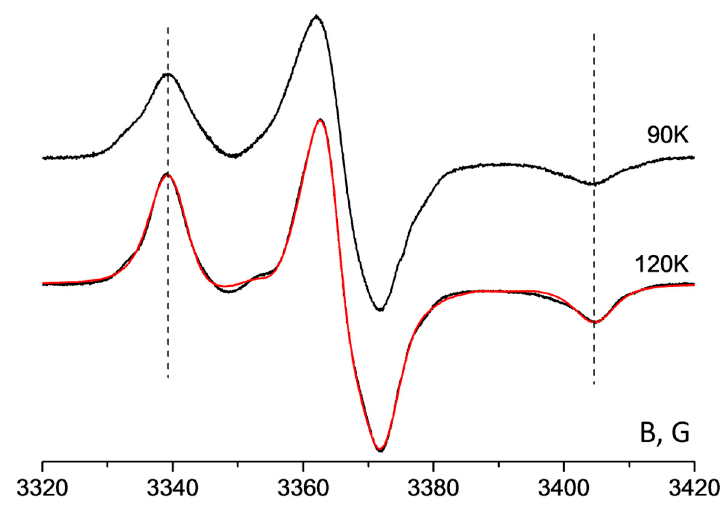
Figure 3. EPR spectra of H1 in frozen toluene. Black lines—experimental spectra, red line—simulation result.